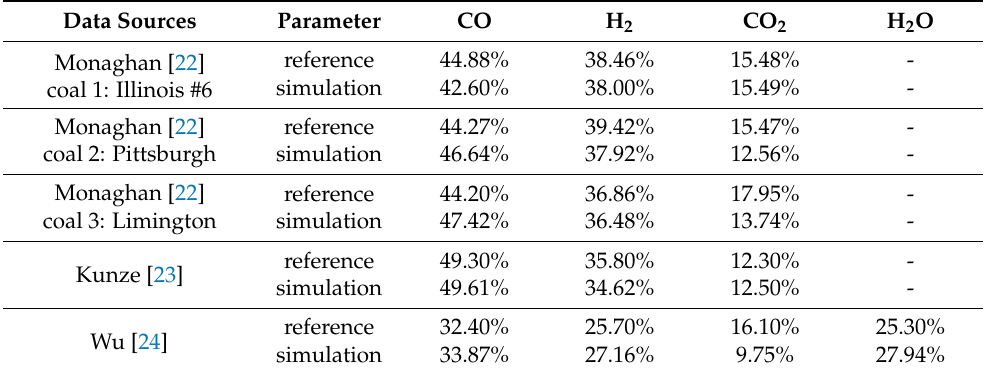
Table 2. Comparison of simulation results of gasifier model with references.